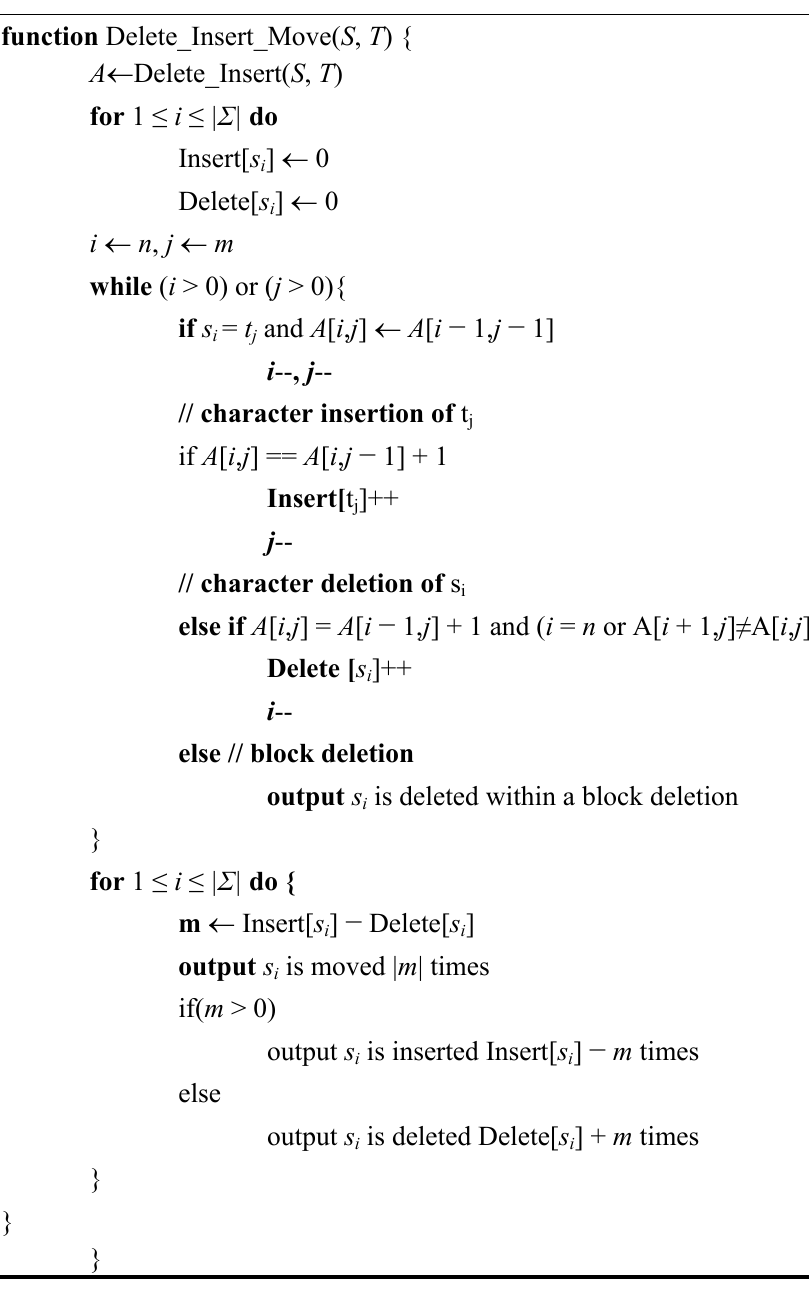
Algorithm 4. Edit Distance with Block Deletions, Character Insertion and Character